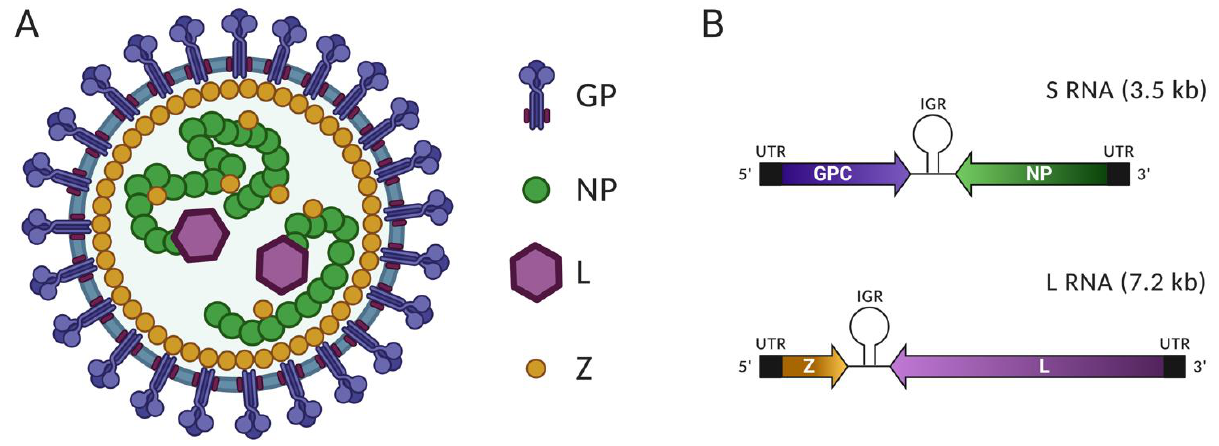
Figure 1. Mammarenavirus virion and genome organization. ( A ) Schematic diagram of mammarenavirus virion. The virion is enveloped and contains four types of viral proteins; glycoprotein (GP), nucleoprotein (NP), RdRp (L), the RING finger protein Z. ( B ) Genome organization of mammarenaviruses. The bi-segmented negative sense RNA genome consists of the large (L) and small (S) segments. This ambisense genome organization encodes two independent viral proteins in each segment; GPC and NP in the S segment, Z and L in the L segment.